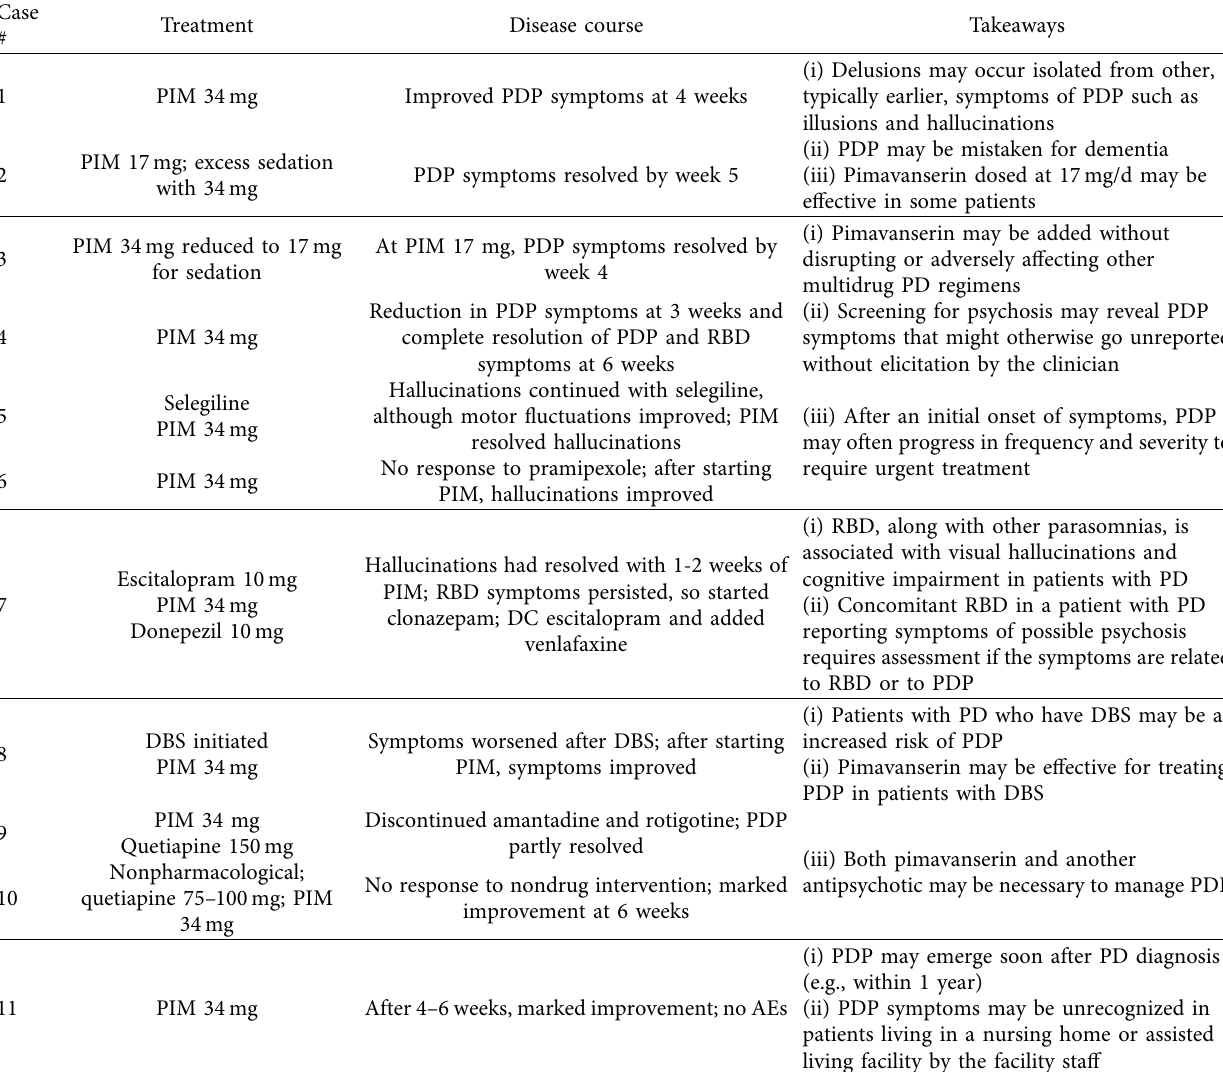
Table 2: Treatment, disease course, and key takeaways from each